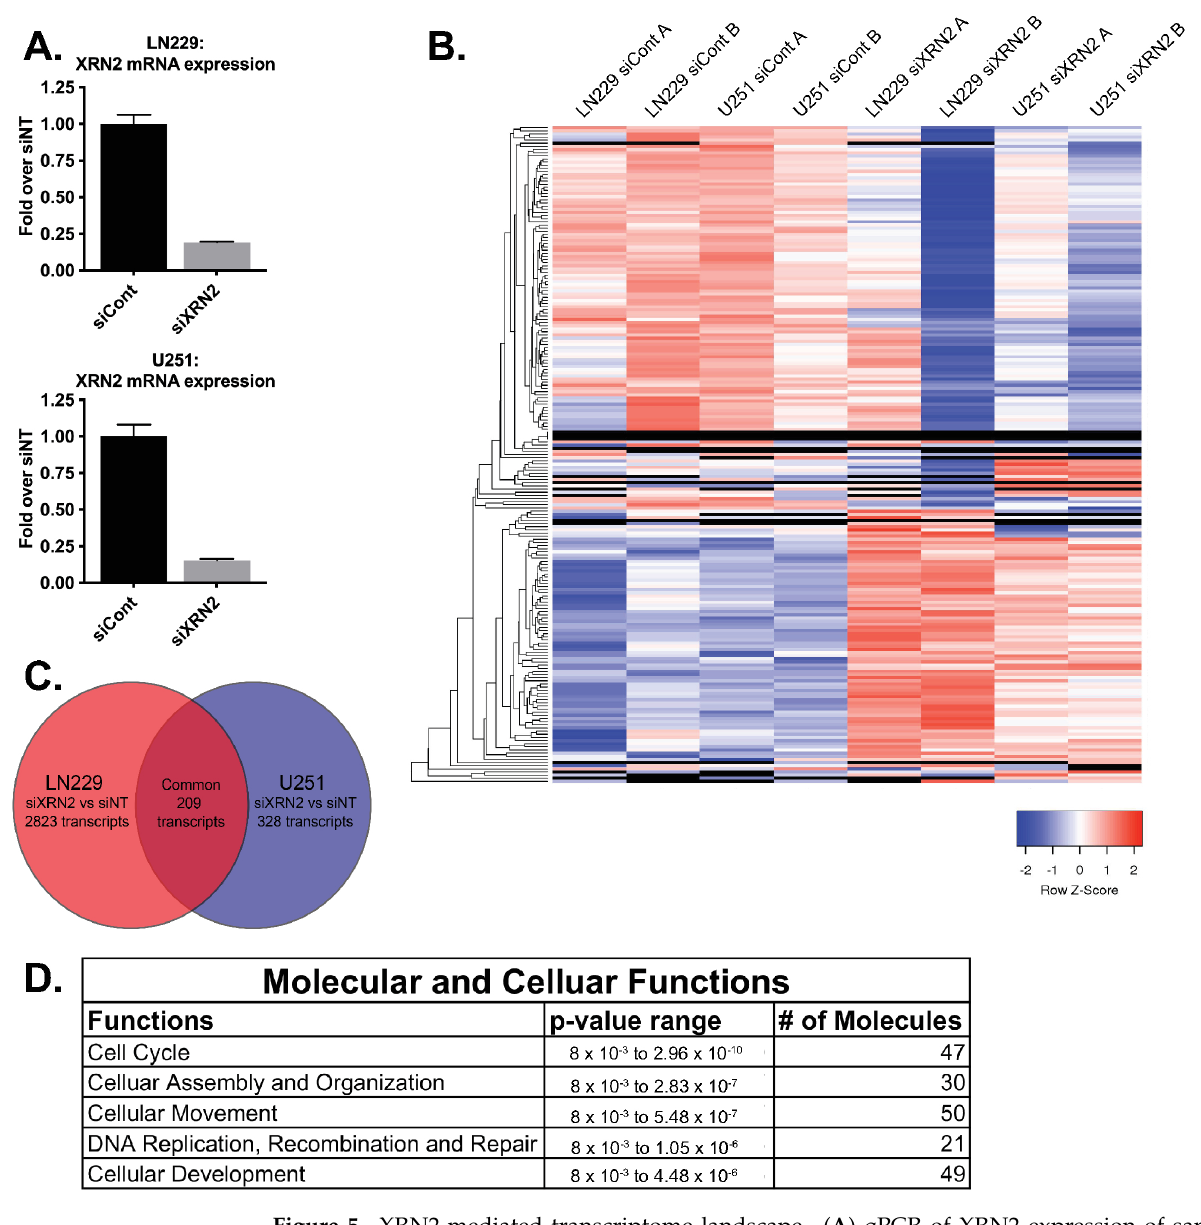
Figure 5. XRN2-mediated transcriptome landscape. ( A ) qPCR of XRN2 expression of samples used in the RNA-Seq in B. ( B ) RNA-Seq heat map of LN229 and U251 transfected with siCont or siXRN2. Heat map generated from transcripts with a log 1.3 or greater change and a p -value of 0.05 or better. ( C ) Venn diagram of overlapping transcripts from B. ( D ) Ingenuity pathway analysis of the overlapping transcripts in